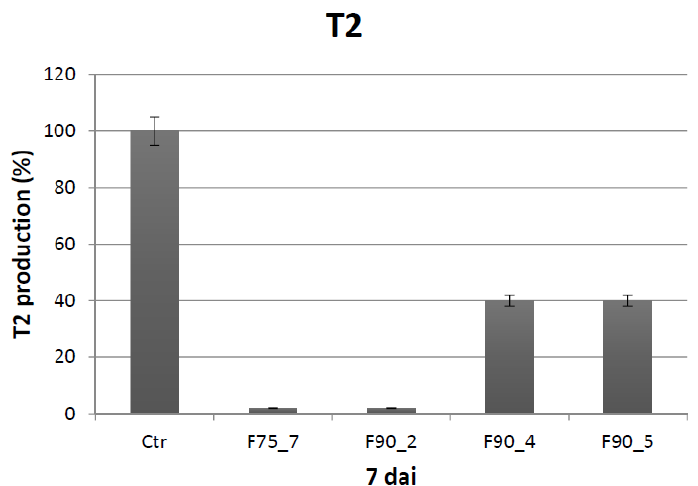
Figure 5. Percentage (%) of T2 toxin produced from F. langsethiae after 7 dai at 25 °C in the absence (Ctr) and presence of sub fractions F75_7, F90_2, F90_4, F90_5. The results are the mean ± SD of 3 different experiments. Table 1. Fungal growth and T2 toxin production by F. langsethiae non treated (ctr) and treated with